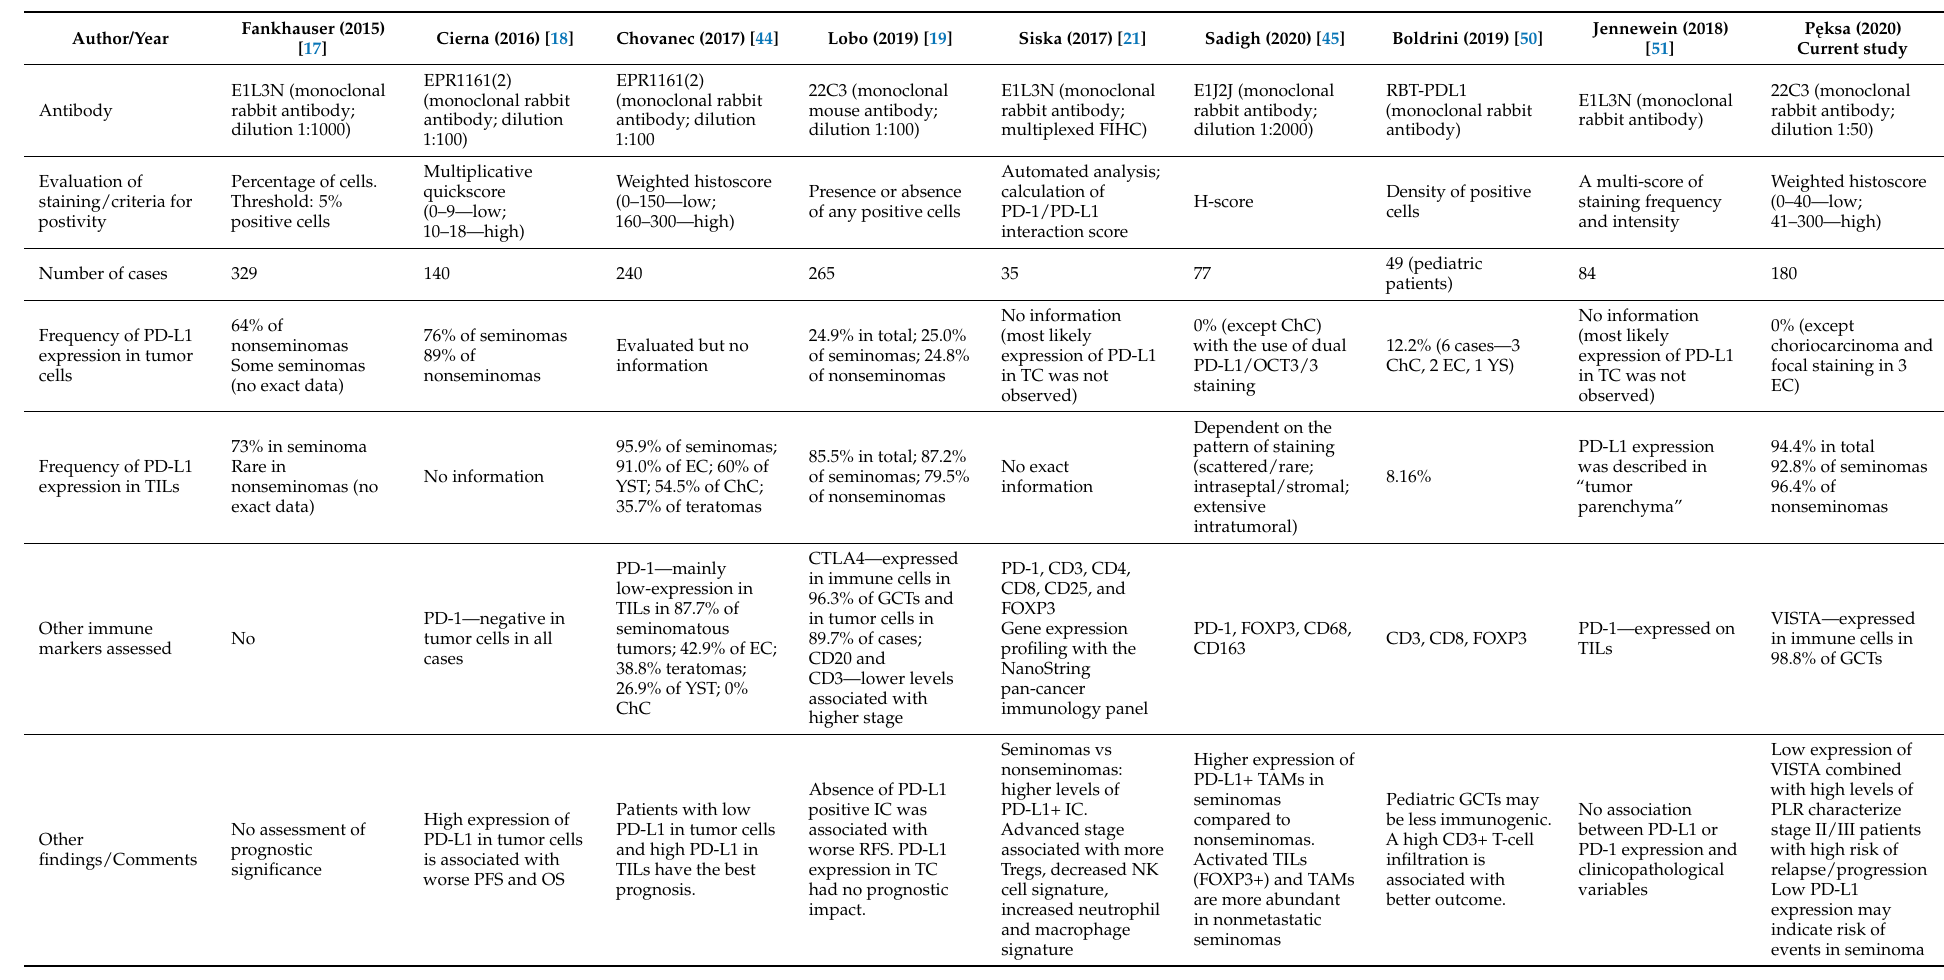
Table 6. The summary of studies investigating expression of PD-L1 in germ cell tumors. Abbreviations: FIHC—fluorescence immunohistochemistry; ChC -choriocarcinoma; EC—embryonal carcinoma; YST—yolk sac tumor; TILs—tumor infiltrating lymphocytes; TAMs—tumor associated macrophages; ICs—immune cells; GCTs—germ cell tumors; PFS—progression-free survival; RFS—relapse-free